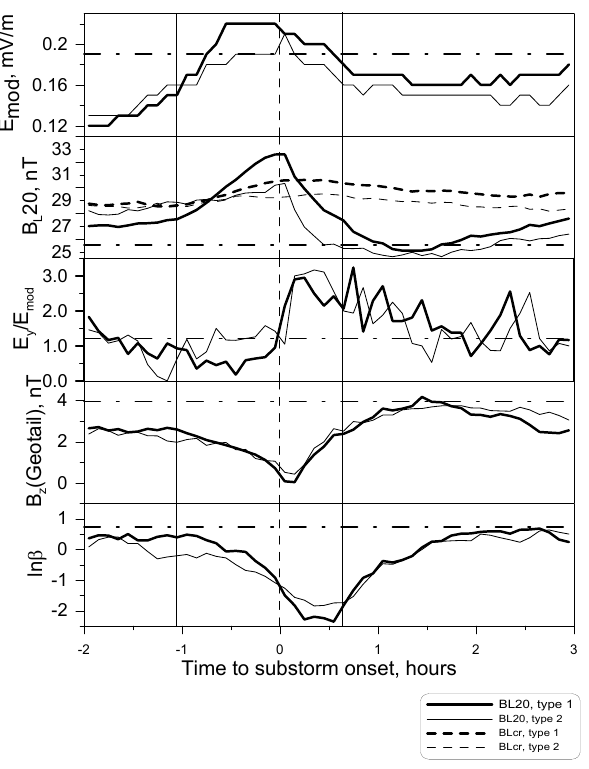
Fig. 3. Variation of the average values of the model electric field (top panel) and plasma sheet parameters for two types of substorms. The dash-dotted line indicates the average SMC values. Solid lines indicate the start of the growth phase (left) and recovery phase (right). The B Lcr was calculated based on IMF and solar wind data using the empirical formula (equation 5c in Shukhtina et al, 2004).